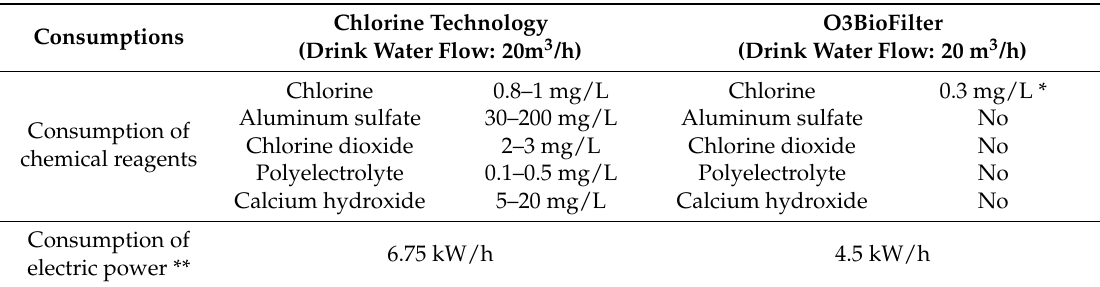
Table 3. Consumption of chemical reagents and electric power of chlorine and O3BioFilter technologies